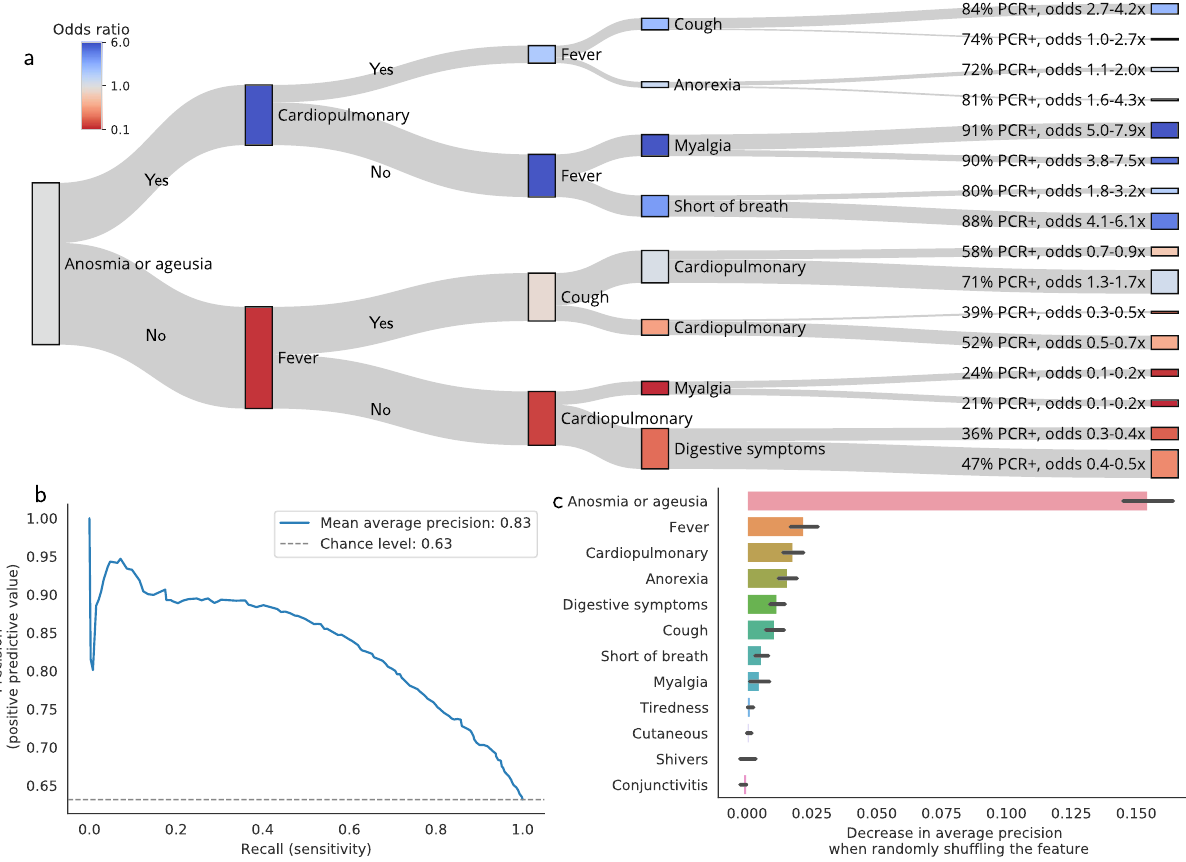
Figure 3. Marginal value of RT-PCR testing in patients with clinically suspected Covid-19 infection. Estimation and evaluation using testing propensity-score weights. ( a ) Decision paths of the tree, applied to evaluation patients . A decision tree classifier is trained on 80% of the tested patients. It predict RT-PCR positivity using 12 features: breathlessness, anorexia, tiredness, digestive signs (diarrhea/vomiting), conjunctivitis,